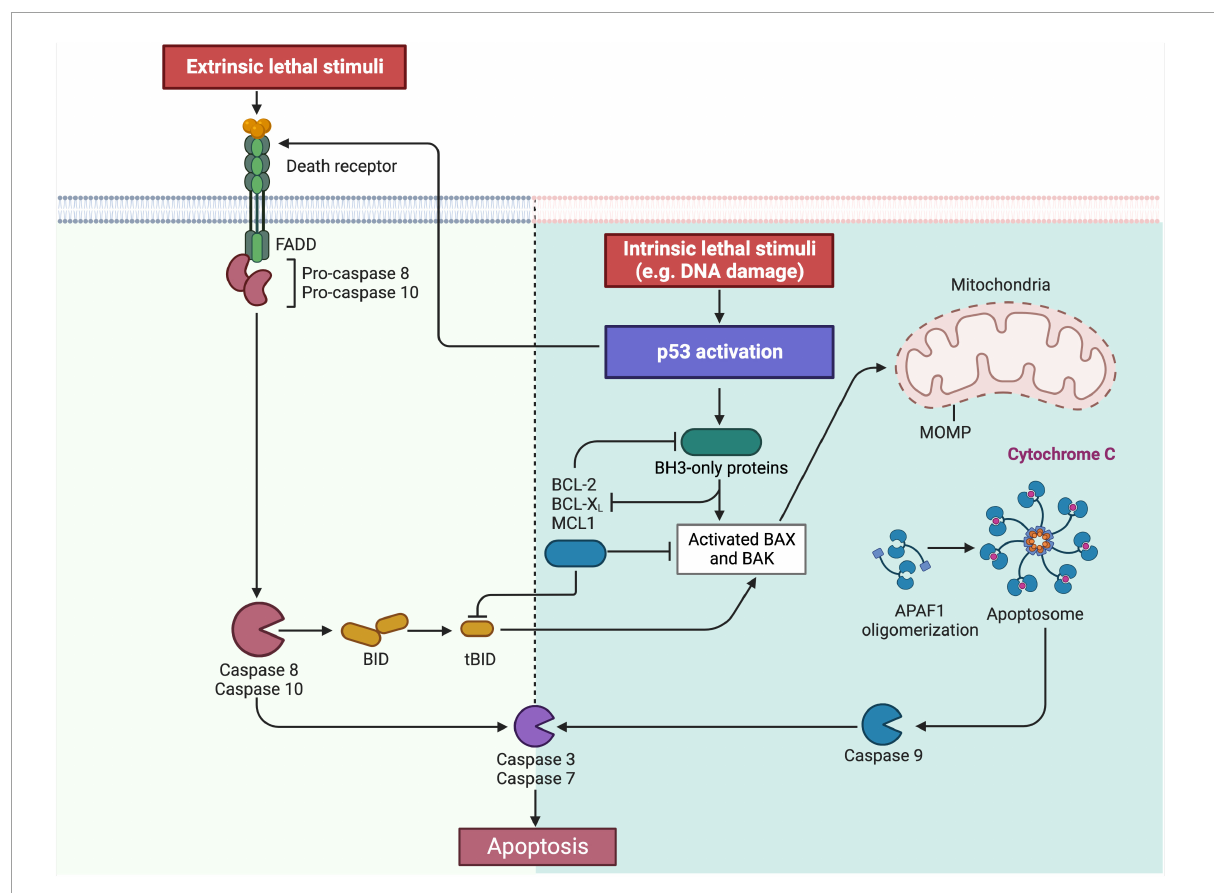
FIGURE2 Overview on the intrinsic and extrinsic apoptosis pathway. As part of the intrinsic pathway, the activation of p53 leads to the increased expression of the BH3-only proteins, which is followed by BAX and BAK. Simultaneously the BH3-only proteins also inhibit the anti-apoptotic proteins BCL-2, BCL-X, and MCL1. This then leads to the permeabilization of the outer mitochondrial membrane (MOMP) of the mitochondria with the consequence of cytochrome c release, apoptosome formation and caspase 9-activation. Contrary, the same anti-apoptotic proteins BCL-2, BCL-X and MCL1 inhibit the BH3-only proteins under physiological conditions in order to prevent apoptosis induction. In the extrinsic pathway, p53 can upregulate so called ”death receptors” in the cell membrane. Following the binding of the respective ligand, the death signal is triggered and transmitted into the cell. This then leads to the activation of caspase 8 and 10. Both pathways finally lead to the induction of caspases 3 and 7, through which the apoptosis is irreversible induced. In addition, the extrinsic and intrinsic apoptosis pathways are also connected by the BH3 interacting domain death agonist (BID), allowing a secondary activation of the intrinsic pathway (Created with